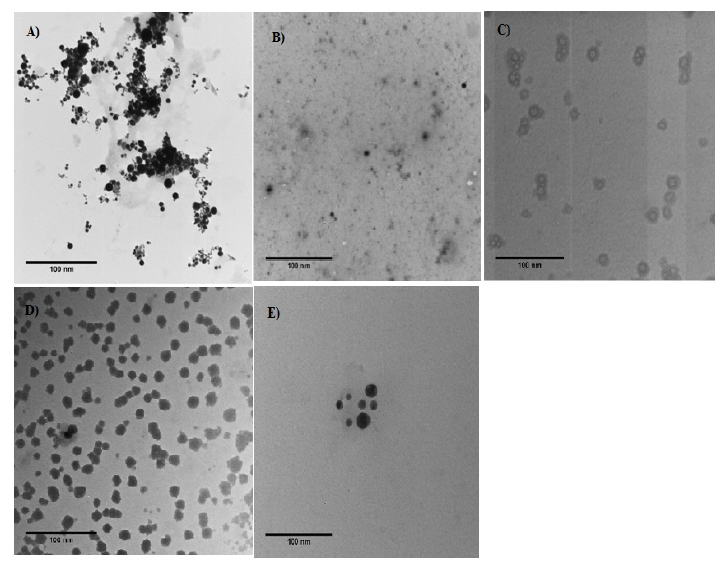
Figure 2. Transmission electron microscope (TEM) images of curcumin-loaded milk protein nanoparticles. ( A ) Cur-SC NPs, ( B ) Cur- α -La NPs, ( C ) Cur- β -lg NPs, ( D ) Cur-WPI NPs, ( E ) Cur-WPC NPs.